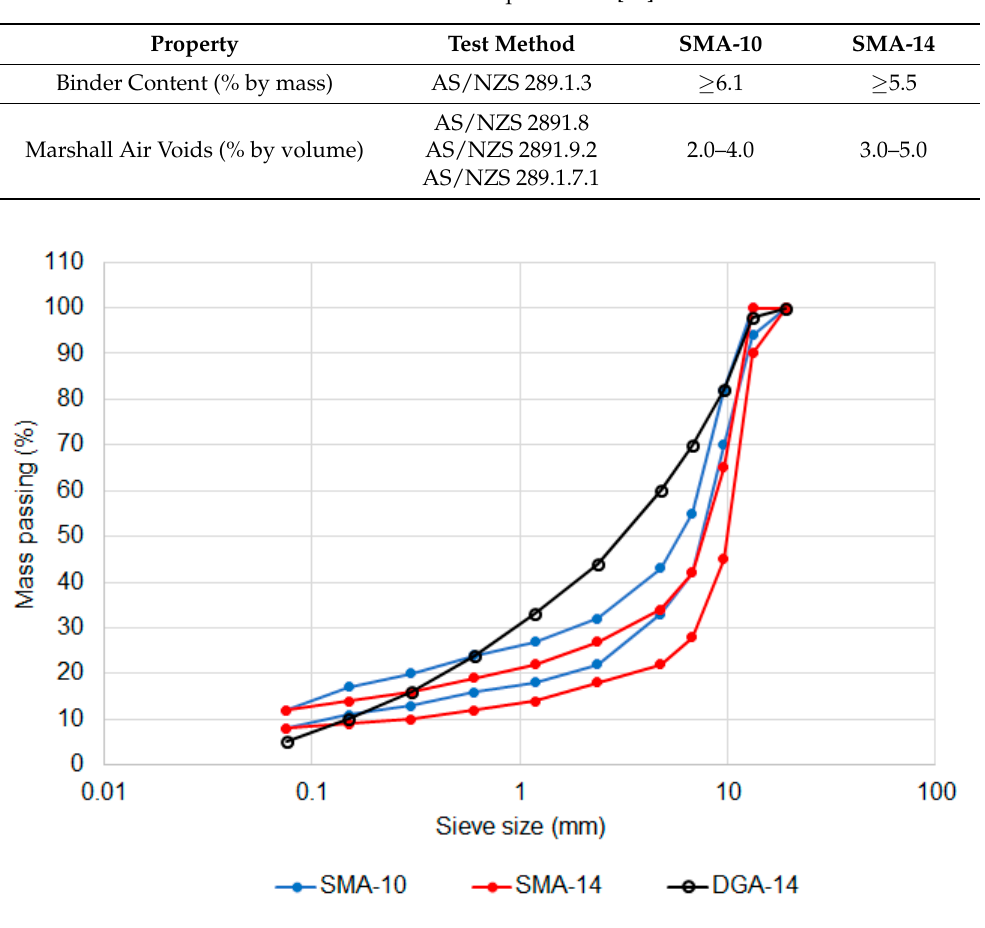
Figure 2. Comparison of SMA-10 and SMA-14 gradation limits.